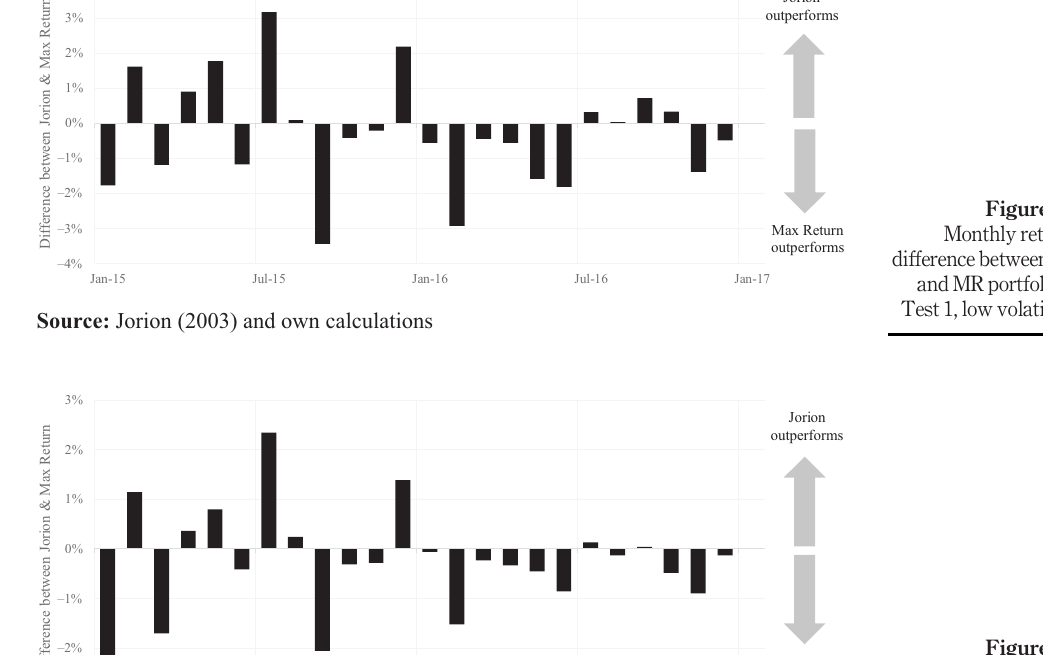
Figure 6. Monthly return difference between JB and MR portfolios, Test 2, low